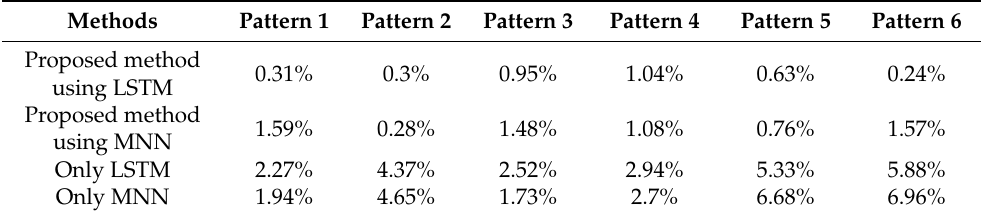
Table 5. The SOC estimation error for each model when two voltage parameters were